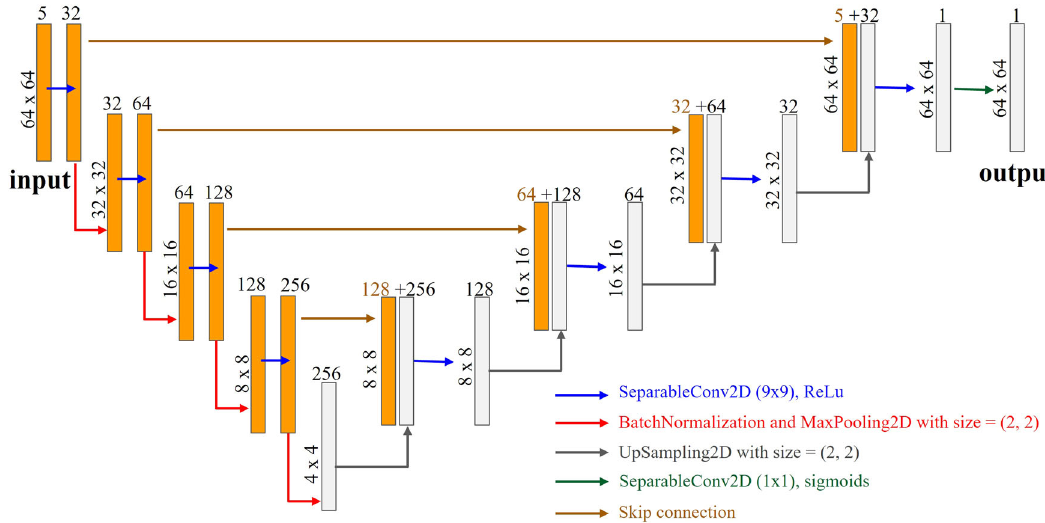
Fig. 12 U-Net-based ANN architecture adopted in this work. Depicted are the number of channels as well as the size of the images in each layer. Employed are two-dimensional (2D) separable convolution with 9 × 9 kernel, ReLU activation, batch normalization, 2D max pooling, and upsampling with bilinear interpolation, all as implemented in TensorFlow 30 . All weights and biases are initialized via the Glorot algorithm 31 . See text for